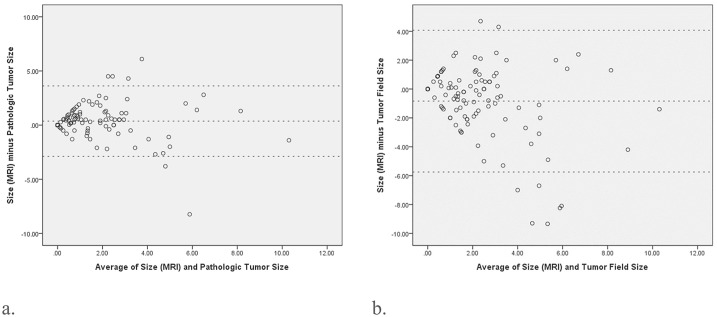
The Bland-Altman plot shows the agreements of the tumor size measurements of MRI scans with pathologic tumor size or tumor field size.(2a) For the pathologic tumor size, the limits of agreement (LOA) are -2.9 and 3.6 cm with corresponding 95% confidence interval (mean bias 0.4cm, SD 1.7cm). (2b) For the tumor field size, the LOA are -5.7cm and 4.1cm with corresponding 95% confidence interval (mean bias—0.8cm, SD 2.5cm).